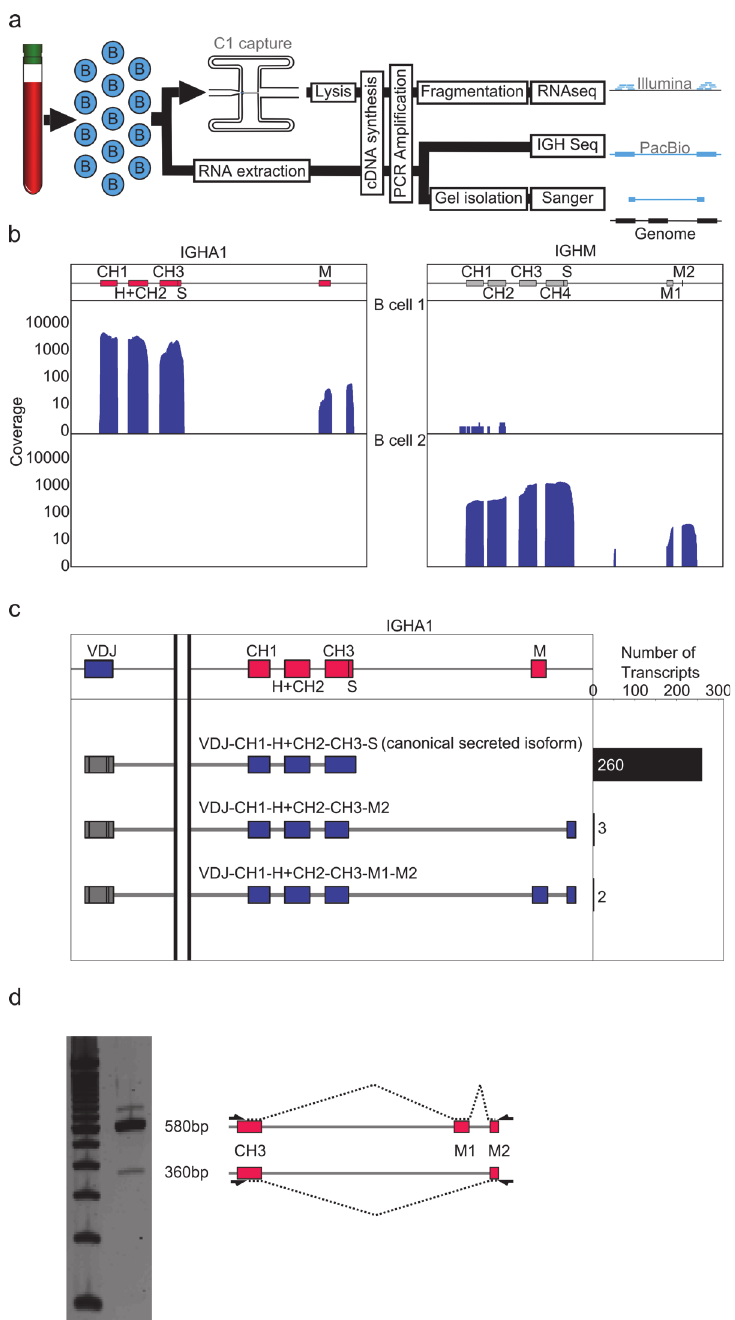
Figure 1. IGHA 3 0 UTR contains novel splice junction. a) Full length cDNA of single B cells was generated using the C1 autoprep system, fragmented using Nextera XT, and sequenced using Illumina sequencers (RNAseq). Additionally, RNA was extracted from bulk B cells and the IGH transcripts were analyzed using the PacBio sequencer (IGH-Seq) or conventional Sanger sequencing after gel isolation b) RNAseq reads of two B cells were aligned to the IGH locus. Coverage density is shown as a histogram for both IGHA1 and IGHM exons for both B cells. Coverage density in the IGHA1 expressing cell indicated a splicing event in the canonical IGHA membrane exon. c) PacBio single molecule sequencing reads were mapped to the IGHA1 locus. Reads containing the whole VDJ region as well as either S or M exons were grouped and quantified. This confirmed the presence of a splice site in the canonical IGHA1 membrane exon resulting in two exons (named IGHA1 M1 and M2). d) Gel separation of amplicons generated from bulk B cell RNA using primers specific for exon J4 and putative exon IGHA1 M2 on the left. Schematic representation of isoform